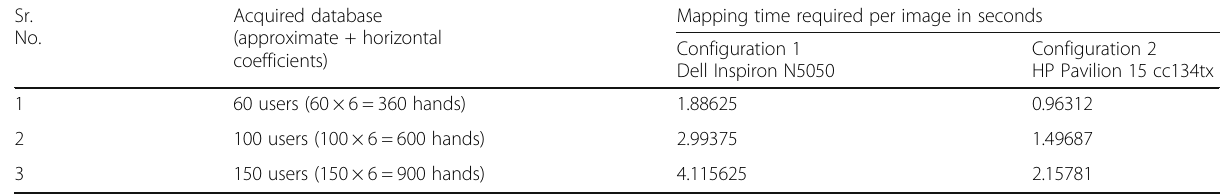
Table 5 Mapping time required using approximate plus horizontal coefficients Sr.